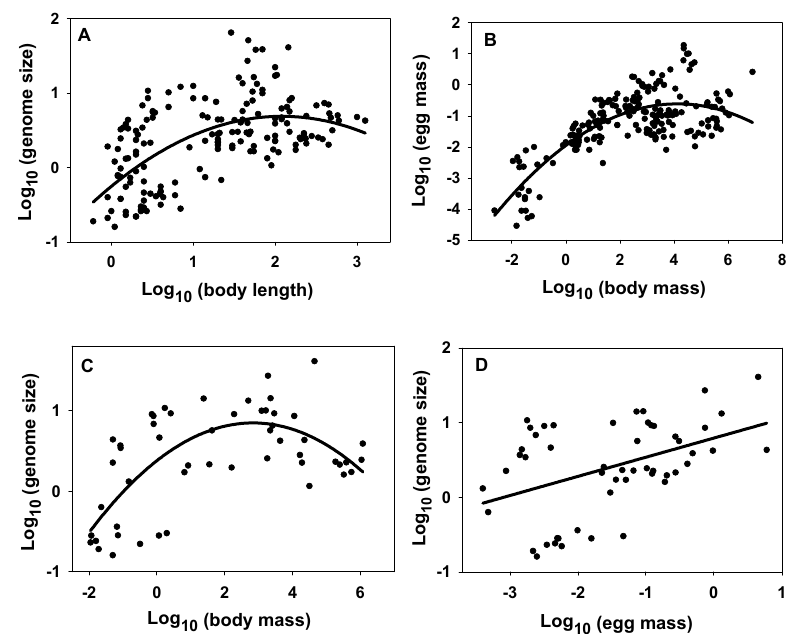
Figure 2. Curvilinear relationships between crustacean genome size (pg) and body length (mm) ( A ), wet egg mass (mg) and wet adult (maternal) body mass (mg) ( B ), and genome size and wet body mass ( C ). Note contrast with linear relationship between genome size and wet egg mass ( D ). All relationships based on log-transformed data in Figure 1 (statistical details in Table 4). Table 4. Statistical details for linear and curvilinear (polynomial, quadratic) scaling relationships between log 10 -transformed values of genome size (pg) versus body length (mm) or body mass (mg), egg mass (mg) versus body mass, and genome size versus egg mass in crustaceans. 1